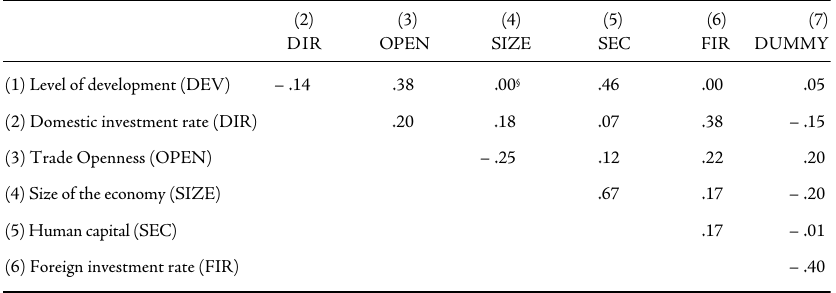
Table A-1c – Bivariate Correlations (Pearson’s r-coefficients) for n=84 DCs and LDCs, 1985–95